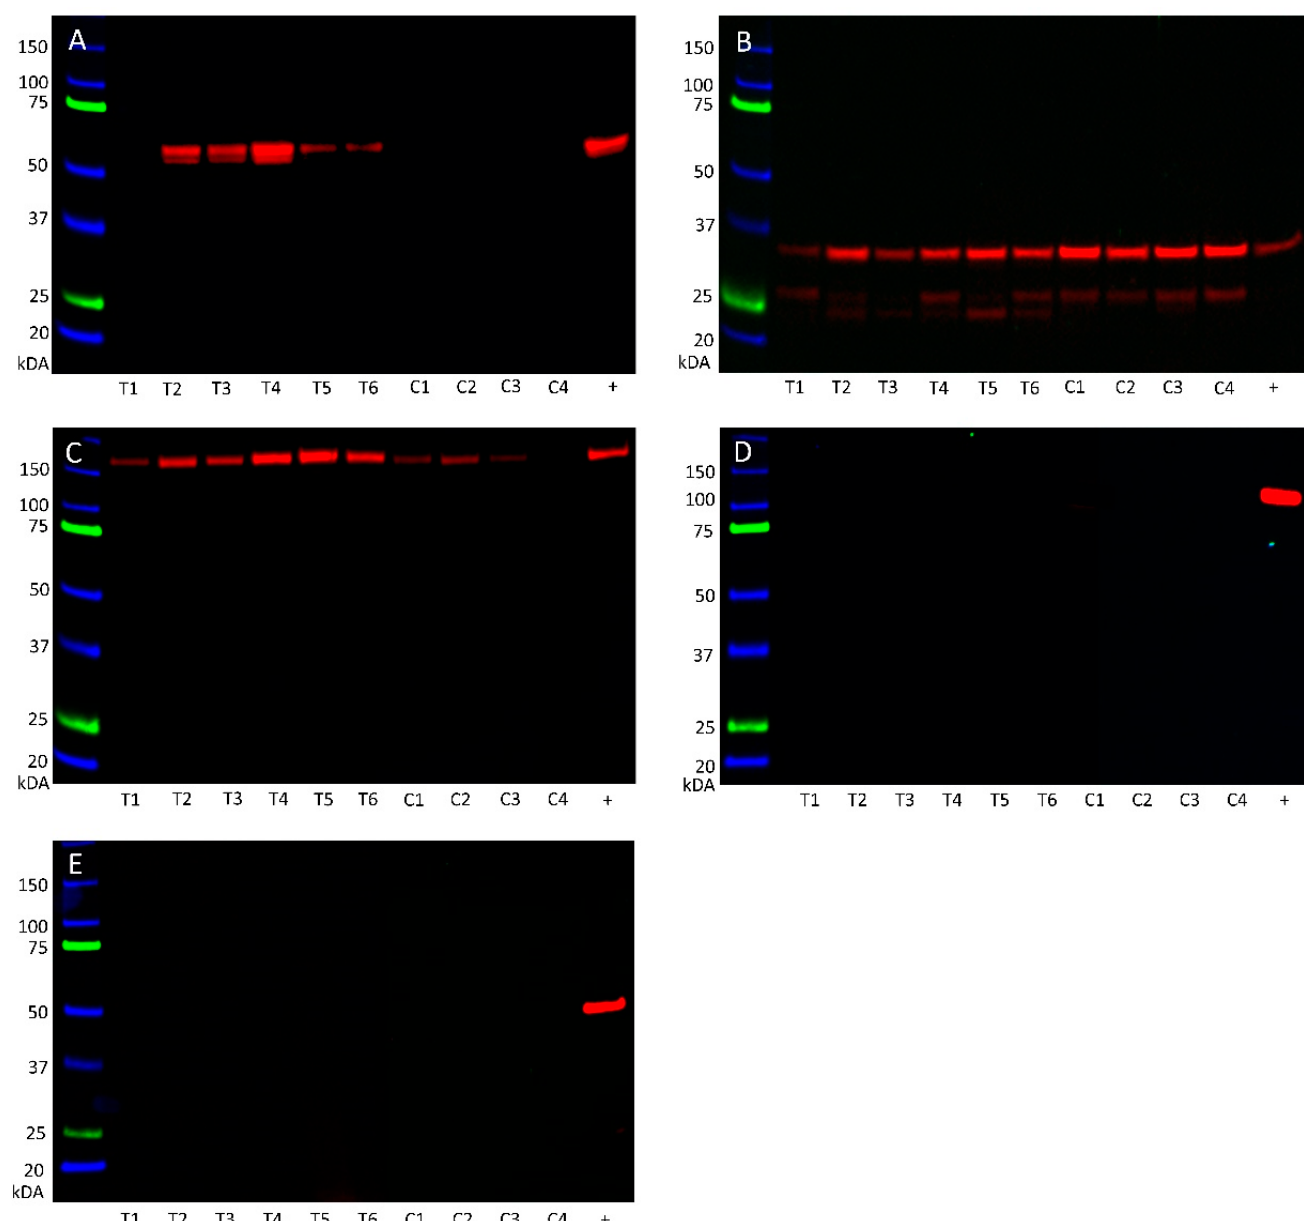
Figure 7. Western blotting of protein extracted from six metastatic head and neck cutaneous squamous cell carcinoma (mHNcSCC) tissue samples (T1–T6) and four mHNcSCC-derived primary cell lines (C1–C4) detected the expression angiotensinogen ( A ) in five of the six tissue samples at the appropriate molecular weight of 55 kDa, but not in any of the mHNcSCC-derived primary cell lines. PRR ( B ) was detected in all of the six tissue samples and four primary cell lines at the expected molecular weight at 35 kDa for the full-length transmembrane isoform and the shorter secreted isoform. ACE ( C ) was detected in all 6 tissue samples, but only three of the four cell lines, at the appropriate weight of 195 kDa. ACE2 ( D ) and AT 2 R ( E ) were not detected in any of the six tissue samples or four primary cell line samples investigated, but were present in the positive controls. Lanes 1–6 indicate six tissue samples used, lanes 7–10 indicate cell lines. +ve indicates positive control: plasma for angiotensinogen; tonsil for PRR; mouse lung for ACE; kidney for ACE2; and mouse heart for AT 2 R. The molecular weight ladder (kDa) is labeled for each blot. Blots for α -tubulin are presented in Figure S7.